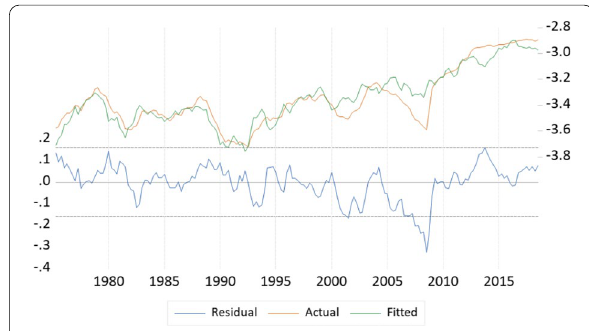
Fig. 2 Fit of FMOLS regression for M2